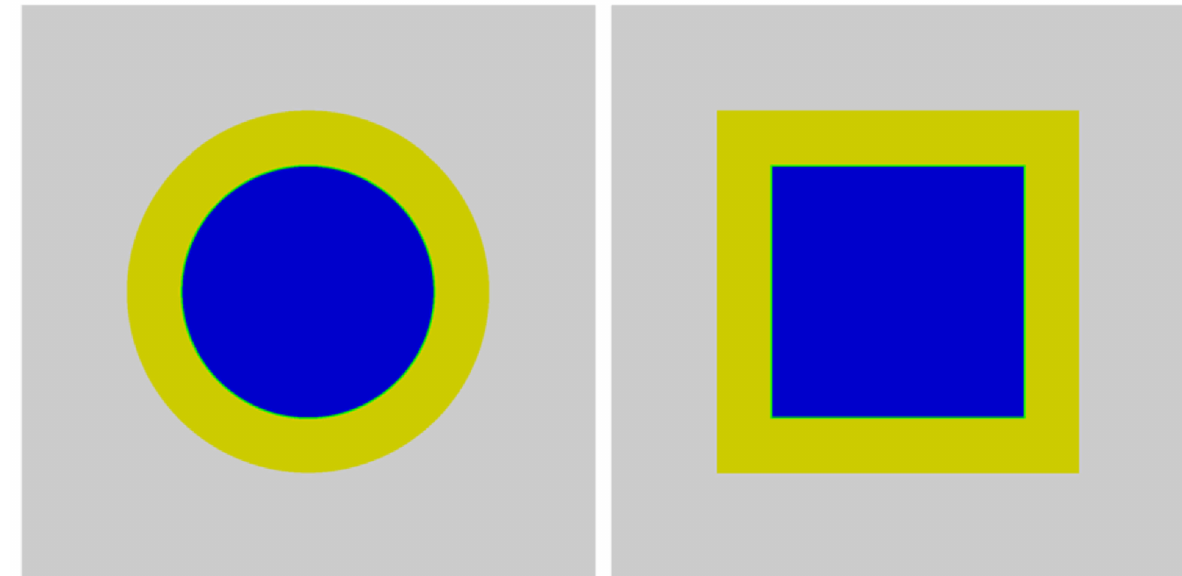
Figure 2. General 3D Monte Carlo (KENO-IV?) model of a configuration with a molten salt fuel core—blue, stainless-steel vessel—light green, reflector—yellow, and vacuum—light gray, developed as the basis for the 3D studies of the proposed control and shutdown approach.